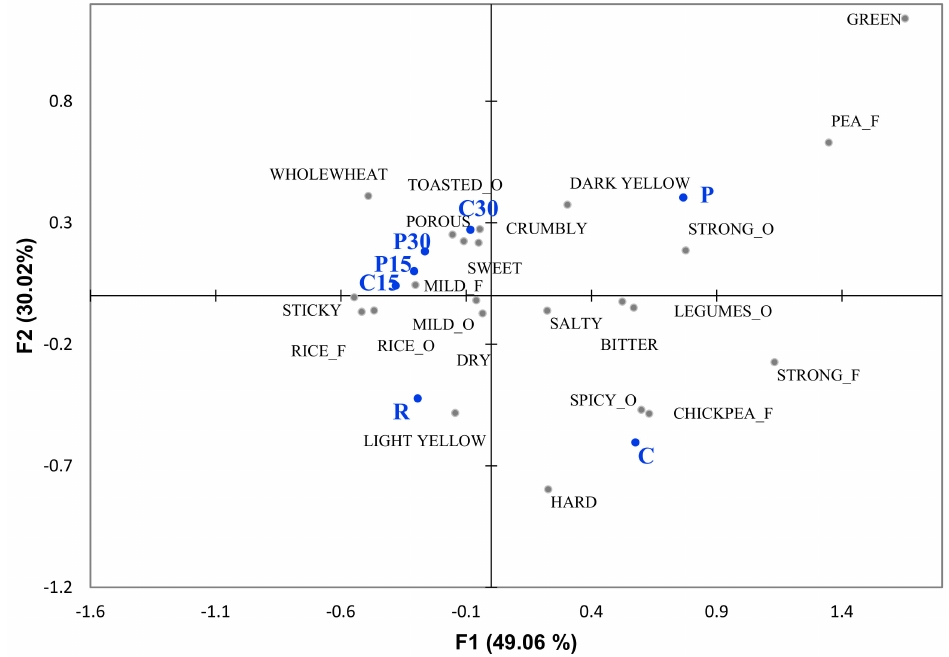
Figure 1. Correspondence analysis from check-all-that-apply data. Snack samples are reported in blue; the sensory attributes in black (O = odor, F = flavor).